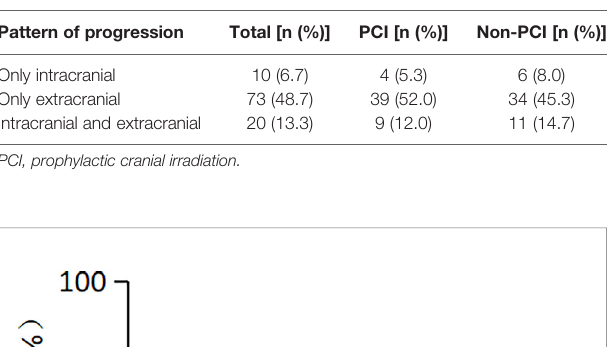
TABLE 2 | Pattern of progression, after propensity score matching.